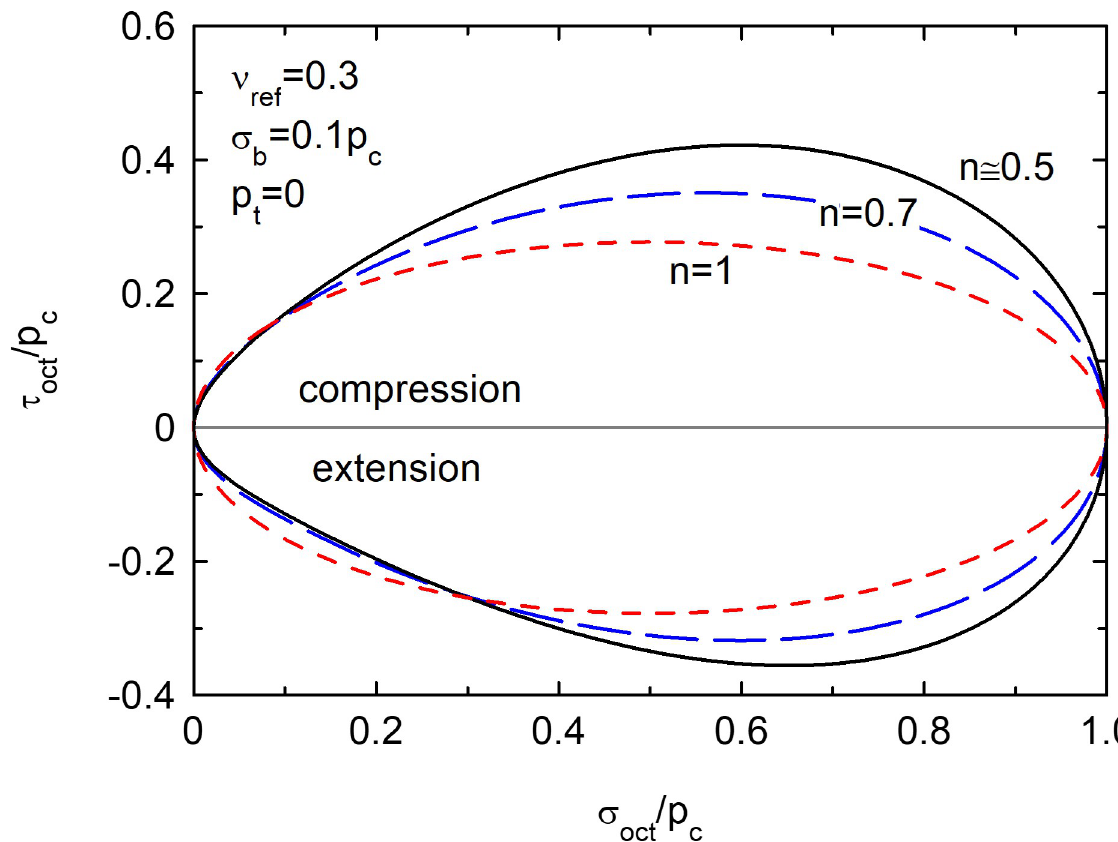
Fig 10. Non-linear elastic potentials in octahedral stress plot for the triaxial plane ( σ 2 = σ 3 ).